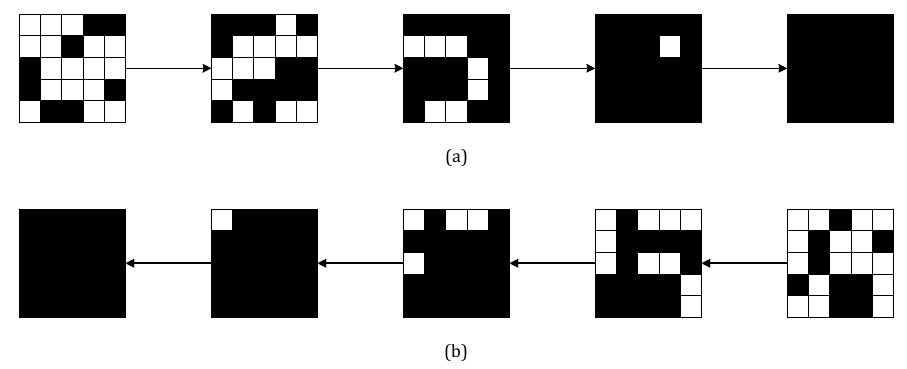
Figure 4. Characteristic matrix’s transformation. White box denotes an entry equaled to 1, while black box denotes an entry equaled to 0. ( a ) The transformation of ACE’s encryption characteristic matrix; ( b ) The transformation of ACE’s decryption characteristic